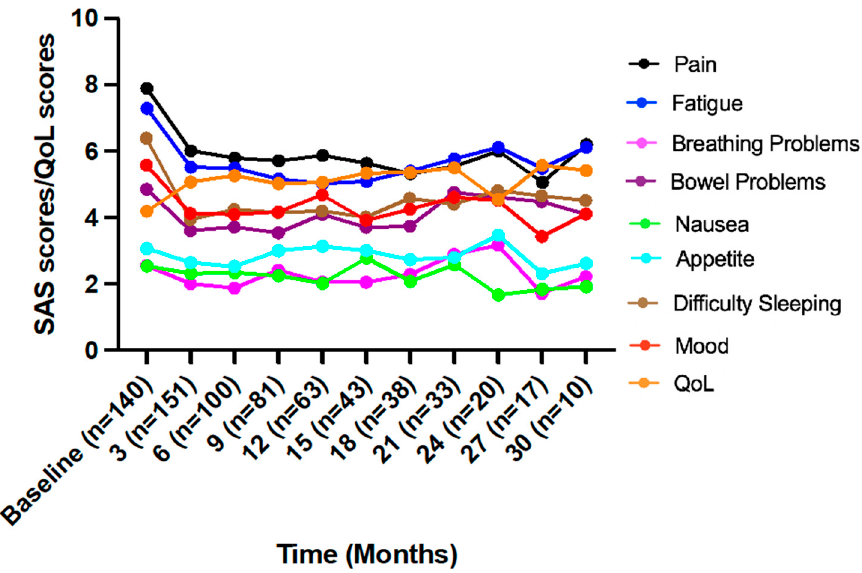
Figure 2. Mean symptom assessment scale scores for all patients assessing symptom distress (10 = worst) and quality of life scores (10 = best). Analysis was possible to 30 months. n: number of patients contributing data at each timepoint; QoL: Quality of life; SAS: Symptom Assessment Scale.